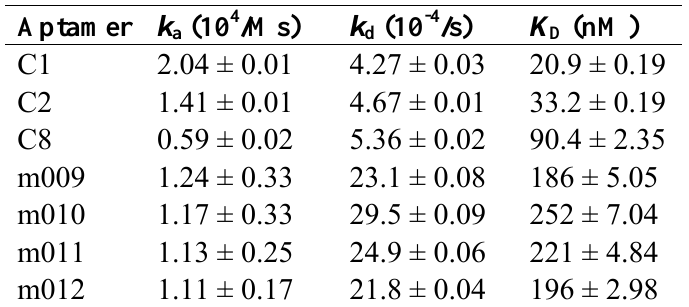
Table 2. Kinetic parameters of the SPC aptamers at 25